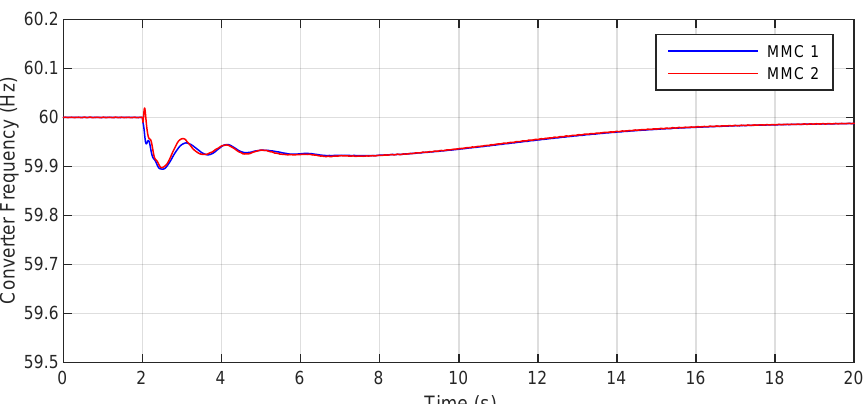
Figure 15. Frequency of the voltage generated at the HVDC converter terminals after the disturbance in Scenario